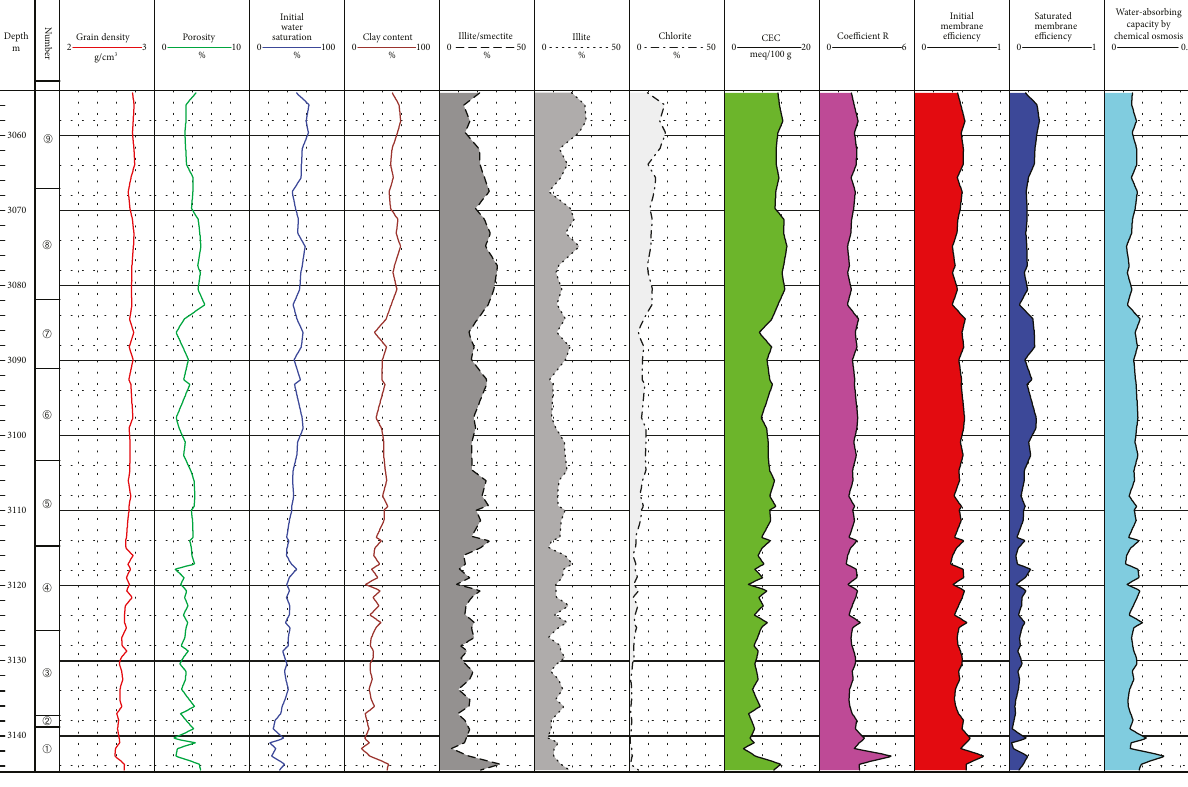
Figure 10 calculates the membrane e ffi ciency of some layers of the reservoir shale by using the average of various physical property parameters. The initial water saturation of each layer shale increases with the number of layers, and the corresponding initial water-saturated membrane e ffi - ciency is close. Membrane e ffi ciency decreases with the increase of water saturation, and the membrane e ffi ciency